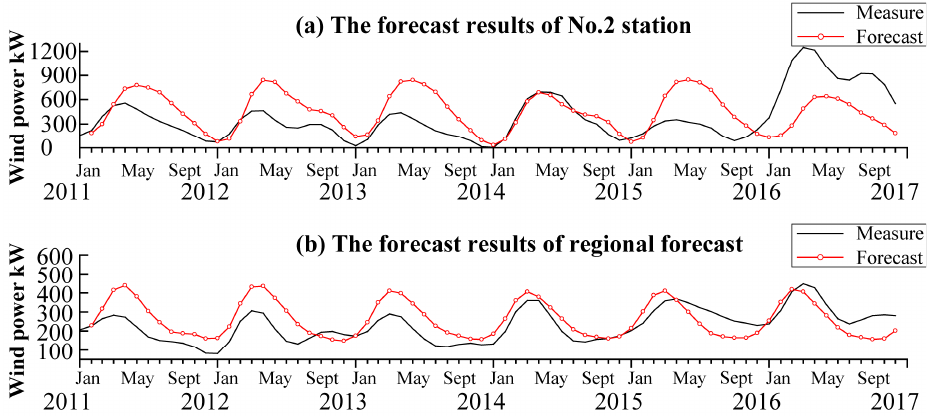
Figure 3. Comparison of site and area forecasts: ( a ) The forecast results of No. 2 station; ( b ) The forecast results of coupling region.